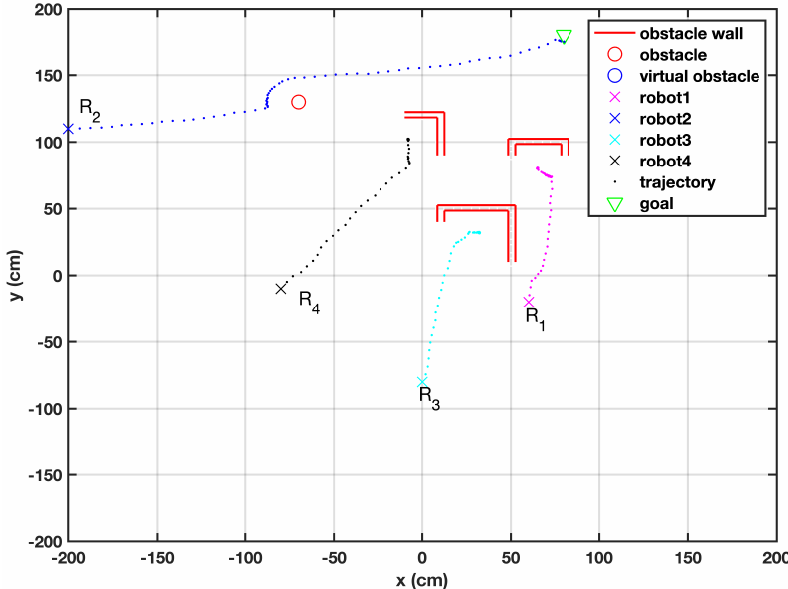
Figure 10. A swarm of robots facing individual obstacles of different shapes.